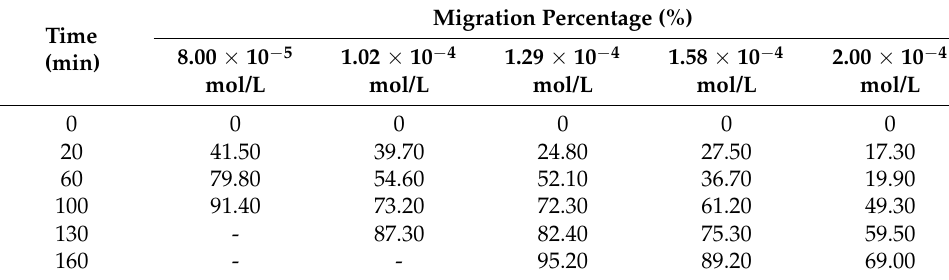
Table 1. Effect of praseodymium(III)